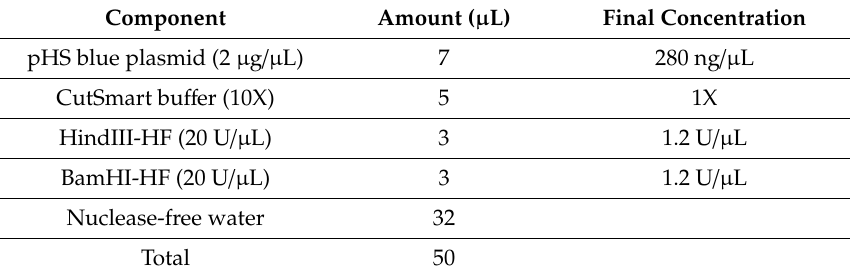
Table 4. Reaction mixture for the digestion of the pHS blue